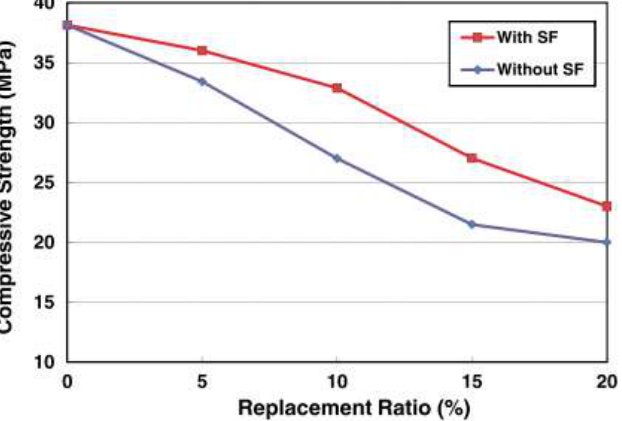
Figure 16. Comparison of compressive strength of test samples [7].